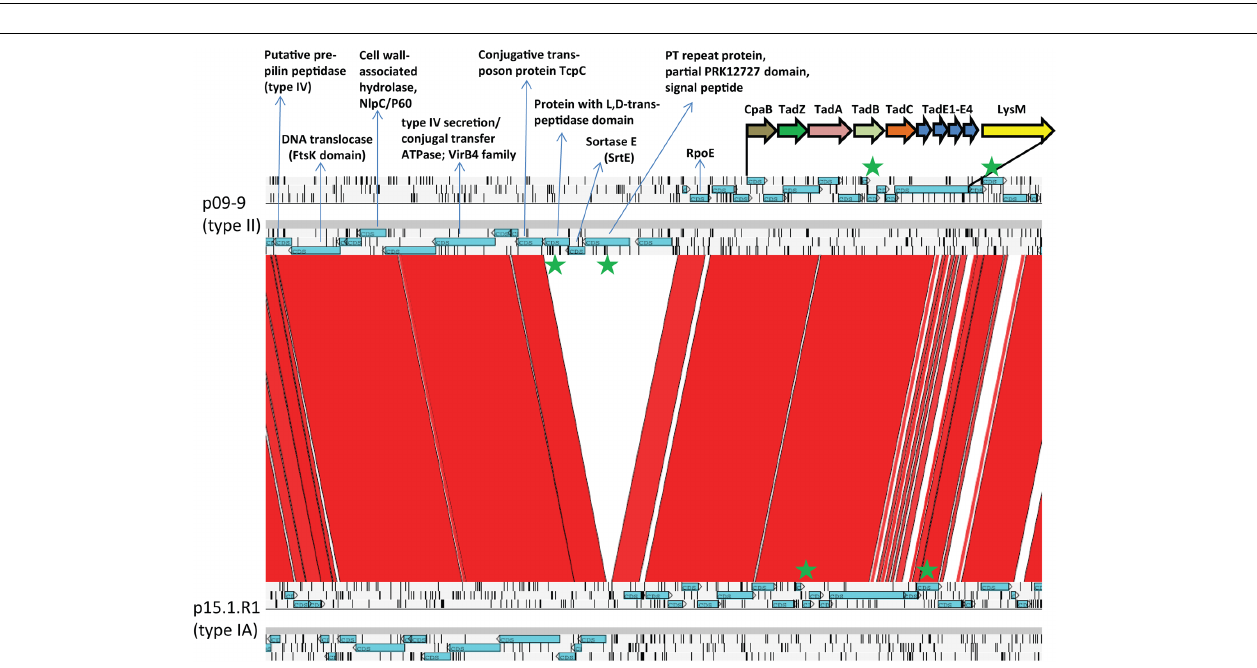
FIGURE 2 | Comparison of 12 large plasmids of C. acnes type I and II strains. (A) The plasmid of the type IA strain 15.1.R1 was taken as the reference sequence and compared to 11 fully sequenced plasmids; (B) the plasmid of the type II strain 09-9 was taken as reference. Type-specific plasmid regions can be detected, e.g., a type IA/IC-specific region at the 5 (cid:48) -end of the plasmid and a type II-specific region in close vicinity to the tad locus. Note the conservation of the tad lcous in all plasmids. The maps were created with BRIG. The jagged line was introduced to illustrate that the plasmids are linear and not circular.